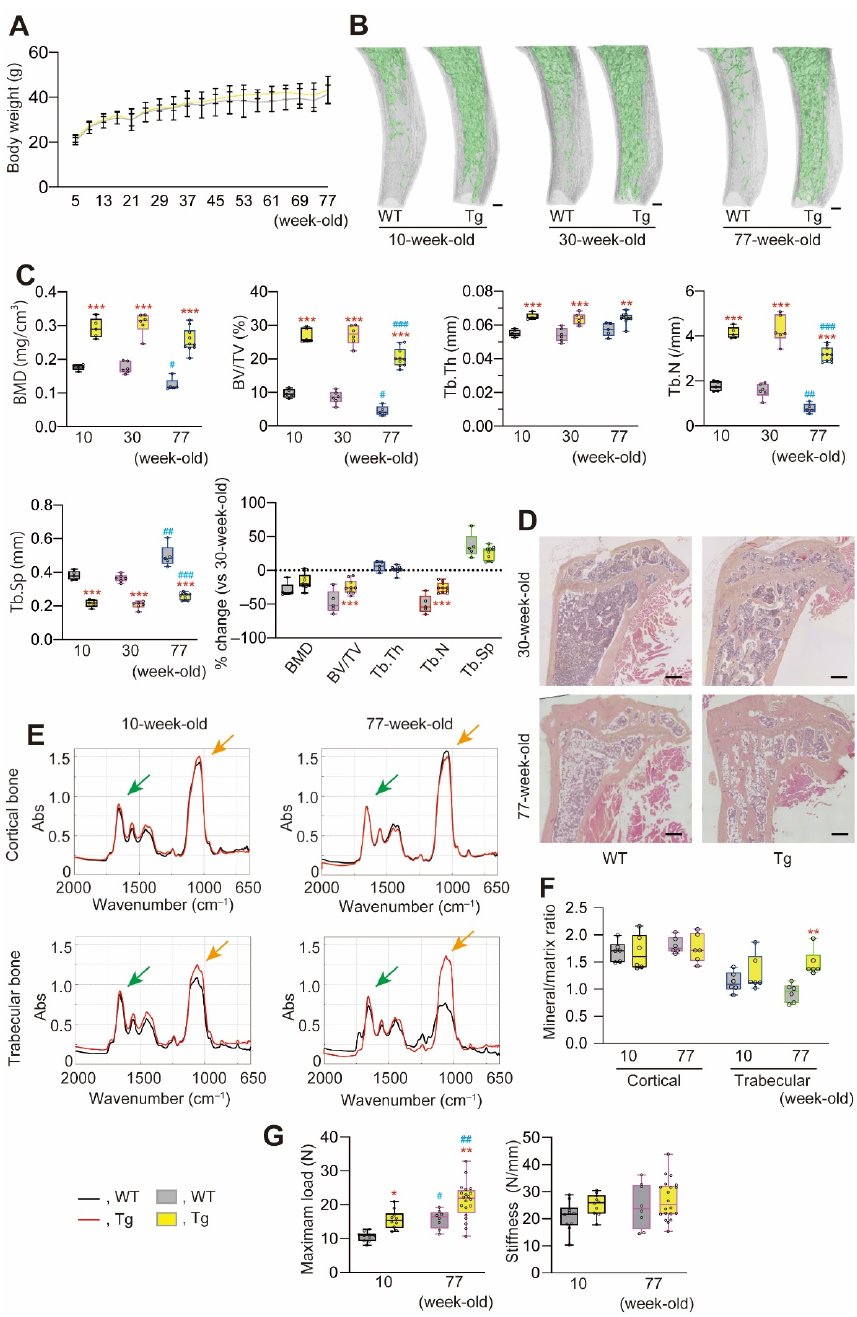
Figure 3. Age-dependent changes in male Tg and WT mouse growth and bone parameters. ( A ) Growth curves of male mice. n = 5 – 10. ( B ) Representative μ CT images of proximal tibiae (longitudinal axis). Green, trabecular bone; gray, cortical bone. ( C ) Trabecular bone CT parameters in images shown in ( B ). Tb.Th, trabcular thickness; Tb.N, trabecular number; Tb.S, trabecular separation. ROI, metaphyseal region with 7 m thickness, based on the position 1 m away from the distal tibial growth plate. n = 4 – 9. ** p < 0.01, *** p < 0.001 versus matched WT; # p < 0.05, ## p < 0.01, ### p < 0.001 versus matched 10-week-old mice. ( D ) Representative images of proximal tibiae stained with H-E. Scale bars, 250 μ m. ( E ) Representative FTIR spectra of WT and Tg tibiae. Green/orange arrows, peaks of Amide I and PO 4 3– indicate collagen and mineral, respectively. ( F ) The mineral/matrix ratio was calculated from peak values in E . n = 6. ** p < 0.01 versus matched WT. ( G ) The femoral maximum load and stiffness from three-point bending tests. n = 8–20. * p < 0.05, ** p < 0.01 versus matched WT; # p < 0.05, ## p < 0.01 versus matched 10-week-old